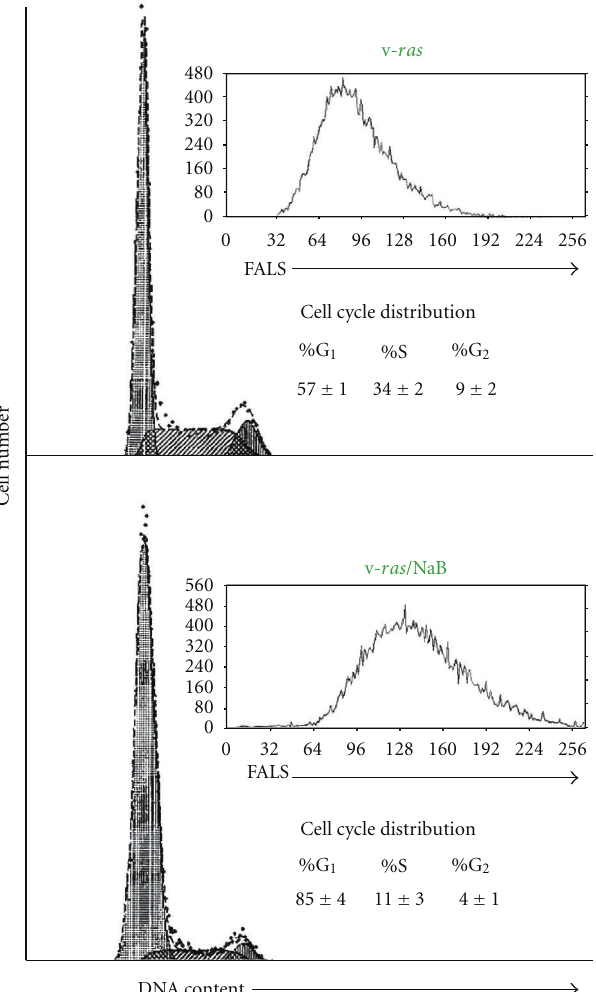
Figure 2: Impact of NaB on cell cycle progression in v- ras transformants. The S-phase fraction of exponentially growing (10% FBS) cells approximated > 34% with a tight mean cellular size distribution (mean: channel 80) as assessed by forward angle light scatter (FALS) measurements. NaB treatment resulted in a G 1 block (even in FBS-supplemented medium) and a significantly increased mean size.